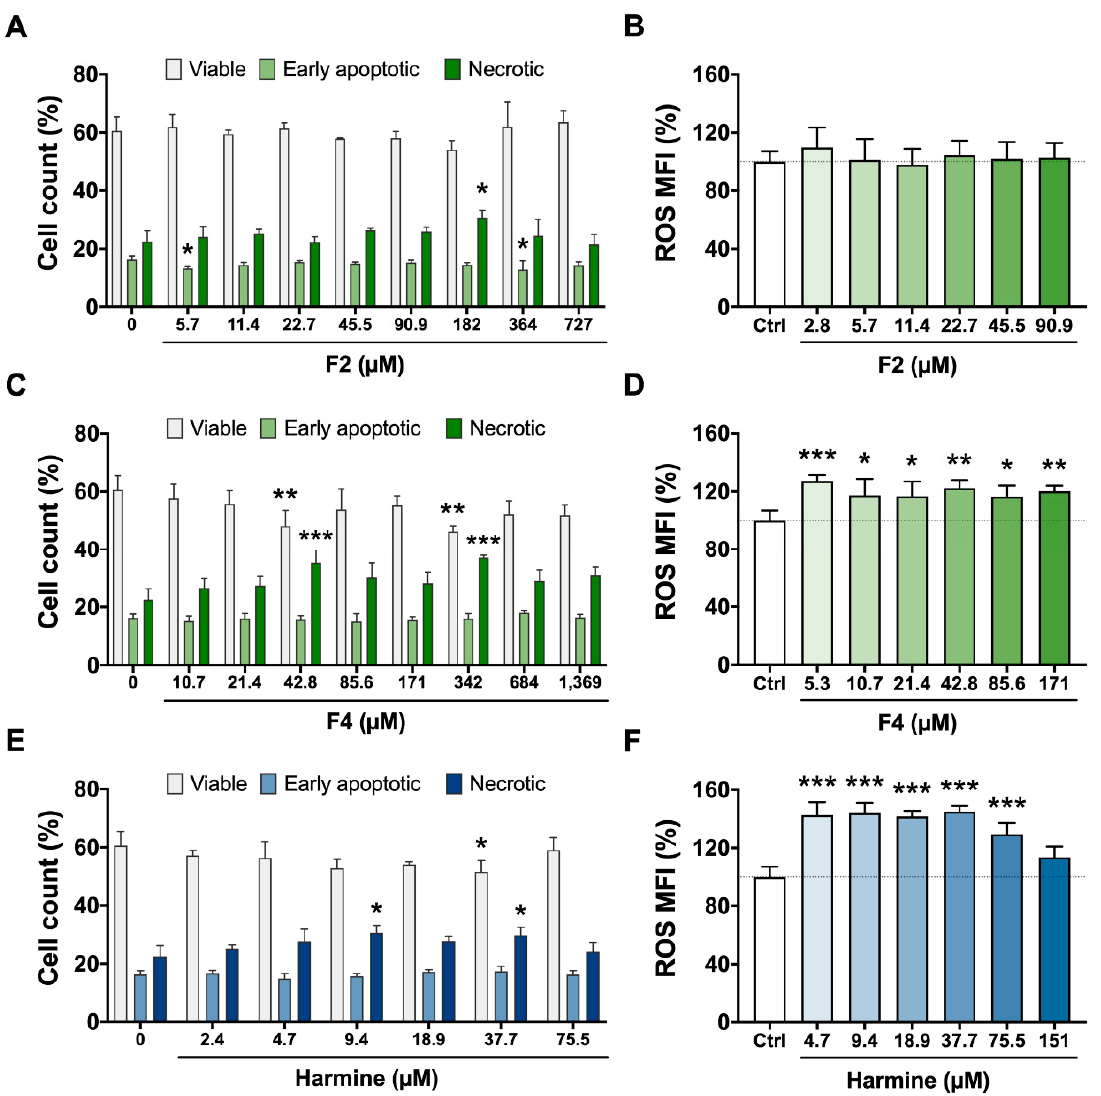
Figure 4. Cell count (left) and ROS production (right) after 24 h in BV-2 cells treated with Banisteriopsis caapi extract fractions F2 ( A , B ) and F4 ( C , D ) and harmine ( E , F ). Values are presented as mean ± SEM ( n = 4–5); * p < 0.05, ** p < 0.01, *** p < 0.001 compared to cells with no treatment (control). Viable + early apoptotic and necrotic cells in all treatments is equal to 100%.